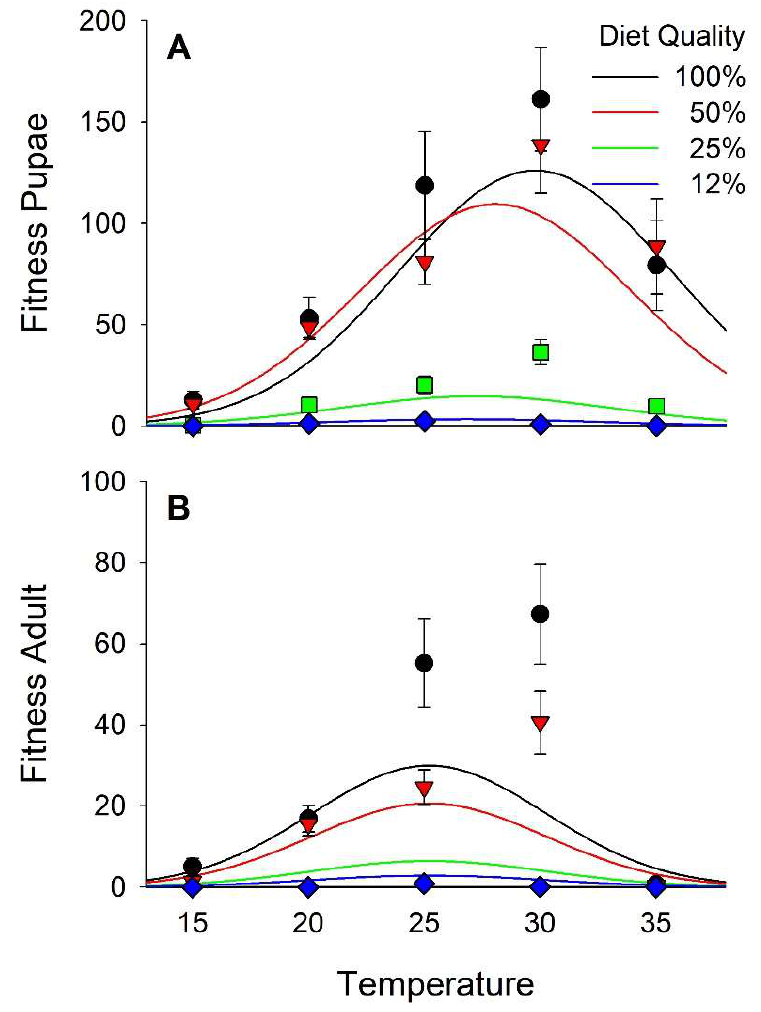
Figure 7. Fitness of pupae (=[Number of pupae per cup × Mean pupal weight] / Mean development time [d]; 𝑥̅ ± SEM; A) and adults (=[Number of adults per cup × mean length of discal medial cell (mm)] / Mean development time [d]; B).